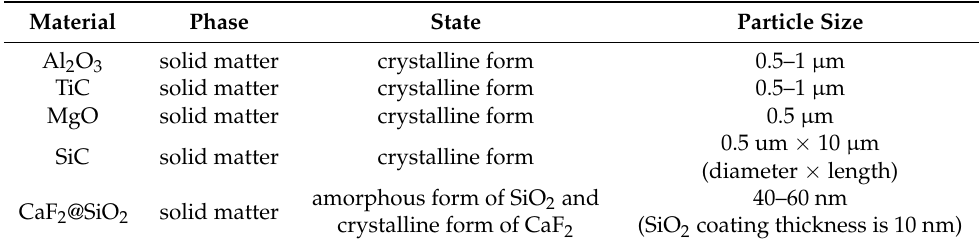
Table 2. The basic information of the raw material